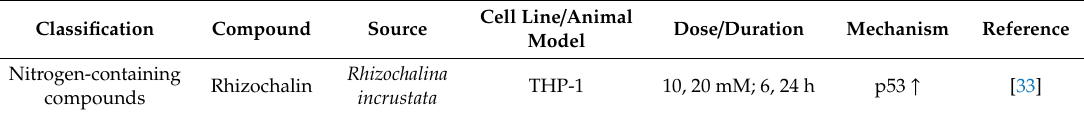
Table 3. Nitrogen-containing